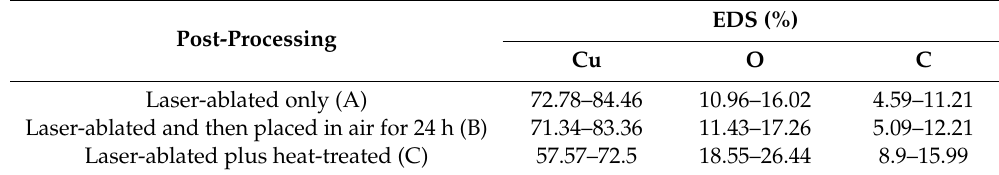
Figure 6. ( a ) The atomic ratio of C/Cu and O/Cu on the surface at different stages; ( b ) apparent contact angle of different stages. Table 3. Energy-dispersive X-ray spectroscopy (EDS) results.